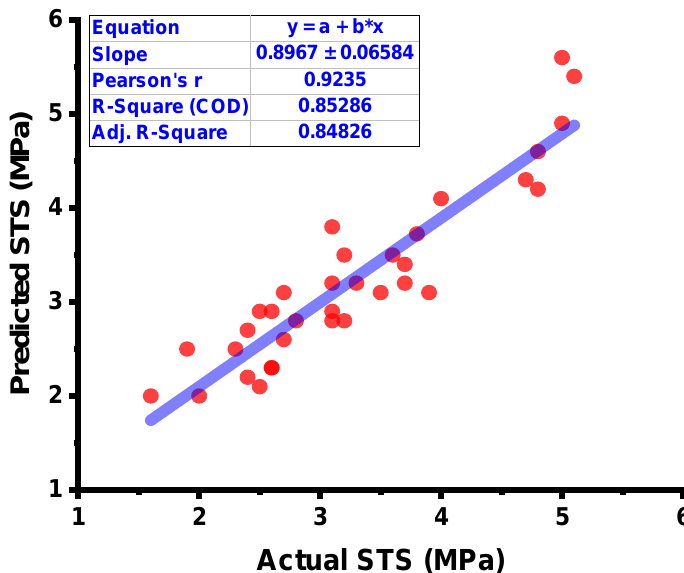
Figure 9. DT model results comparison between the results from laboratory work and predictions.